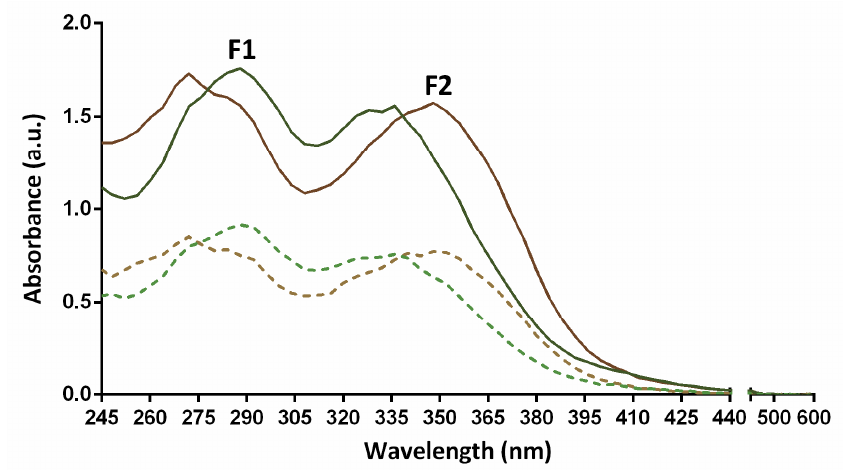
Figure 2. Absorption spectra of the formulations F1 and F2 from 245 to 600 nm. Continuous lines indicate formulation absorption spectra at 100 µg/mL while dashed lines show absorption spectra obtained with 50 µg/mL of formulation.